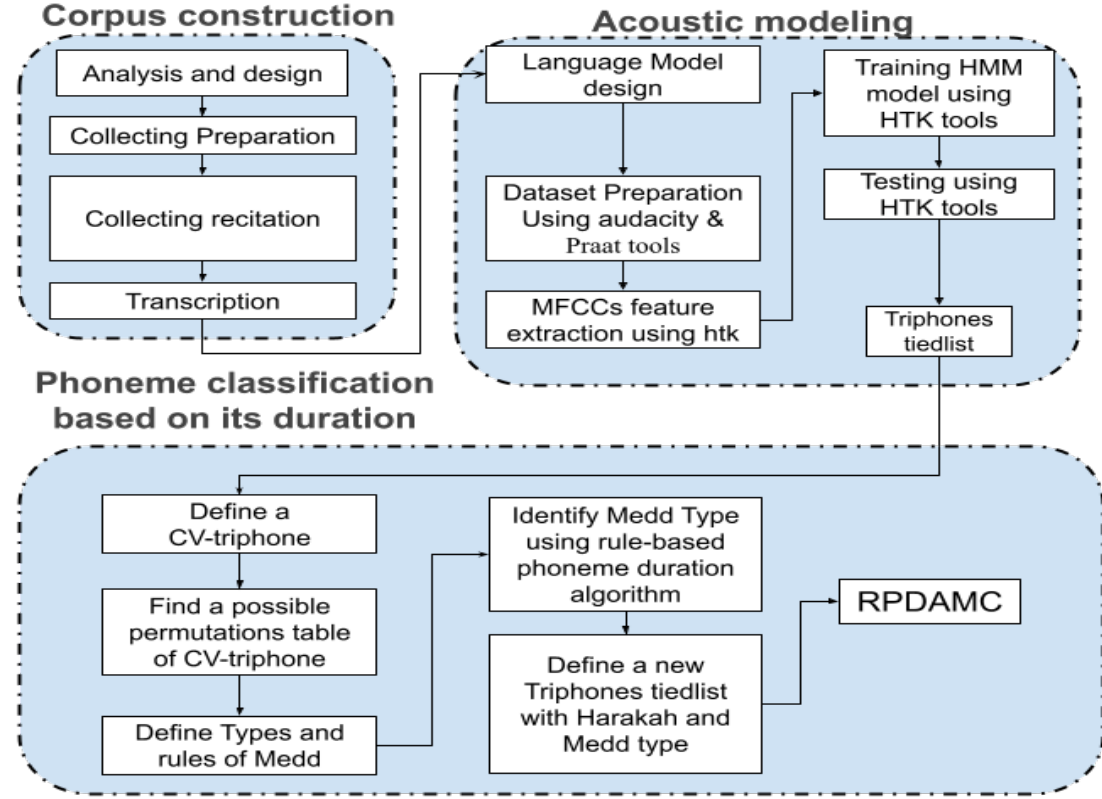
Figure 2. Stages of classification of phonemes based on the rules of Tajweed.